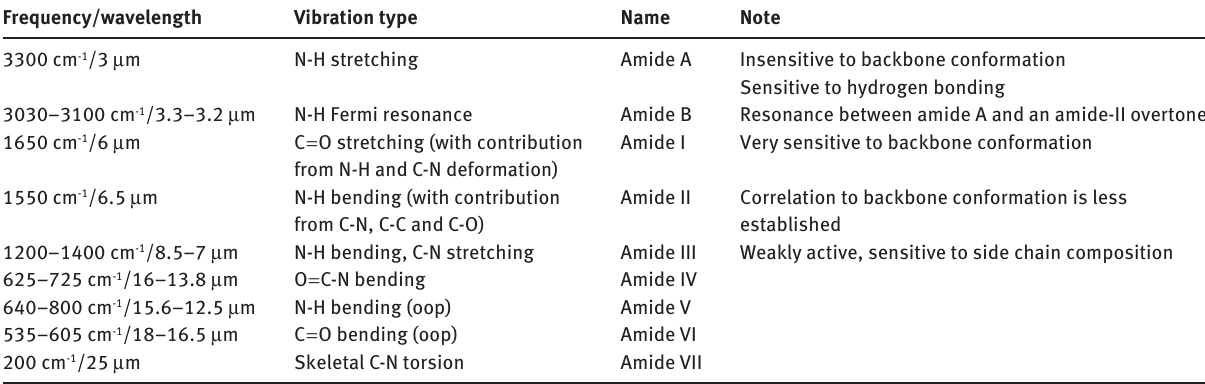
Table 1 IR peaks of peptide bond.